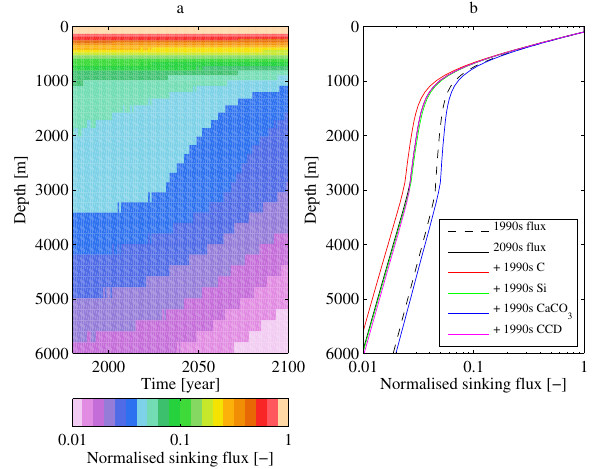
Fig. 22. Change in the vertical profile of normalised attenuation of fast-sinking detritus for the period 1980-2100 (left), and the attri- bution of this to changes in regulating factors (right). In the latter panel, artificial profiles of 2090s attenuation are created by the sub- stitution of 1990s fields of C org , opal, CaCO 3 and CCD